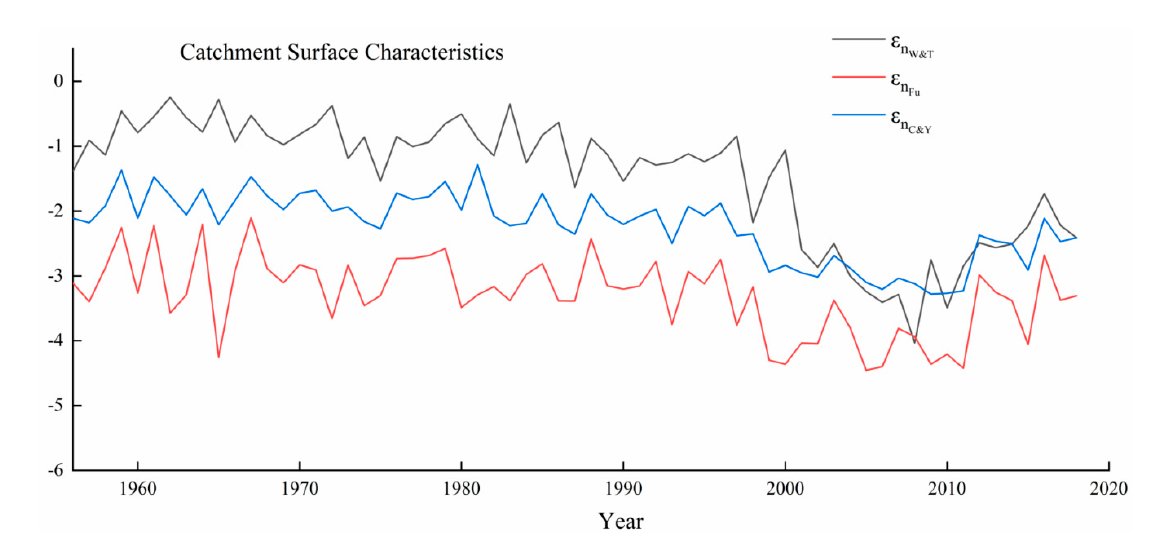
Figure 6. Elasticity coefficients of the potential evapotranspiration for the three Budyko methods from 1956 to 2018.